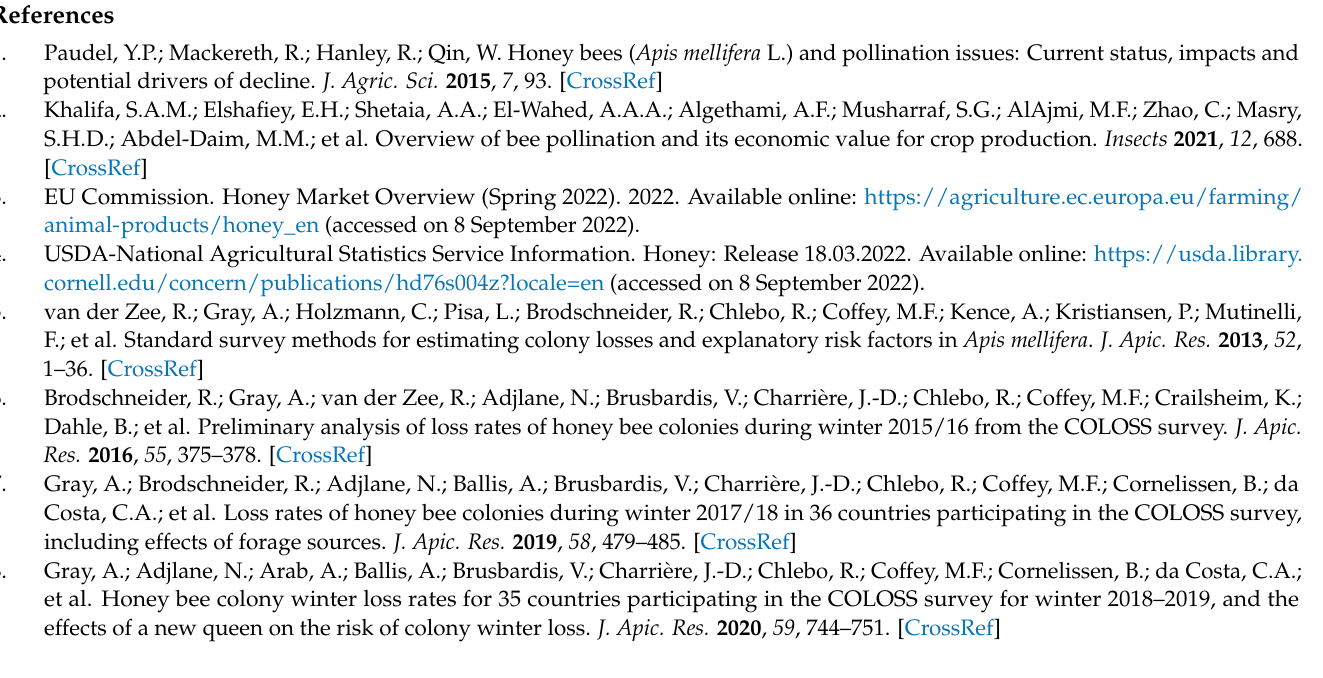
Table S3: Rheinland-Pfalz (RP); Table S4: Administrative